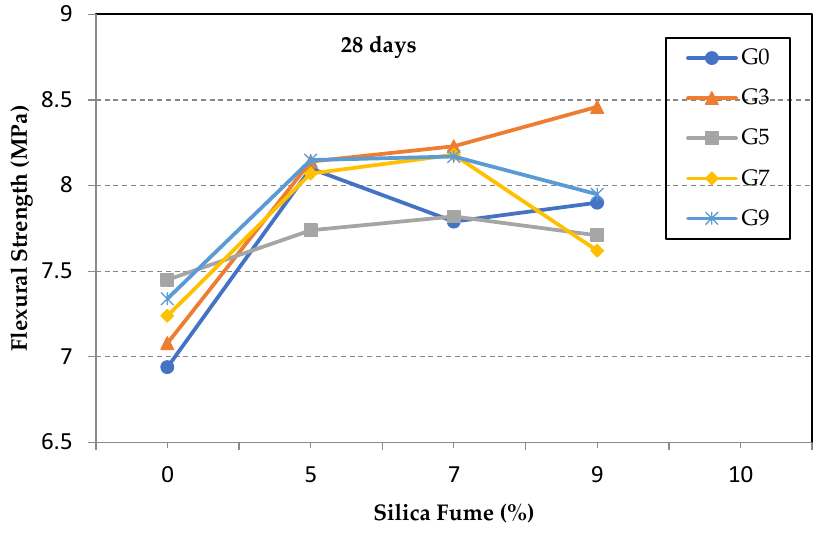
Figure 4. Flexural strength of test specimens at 28 days.